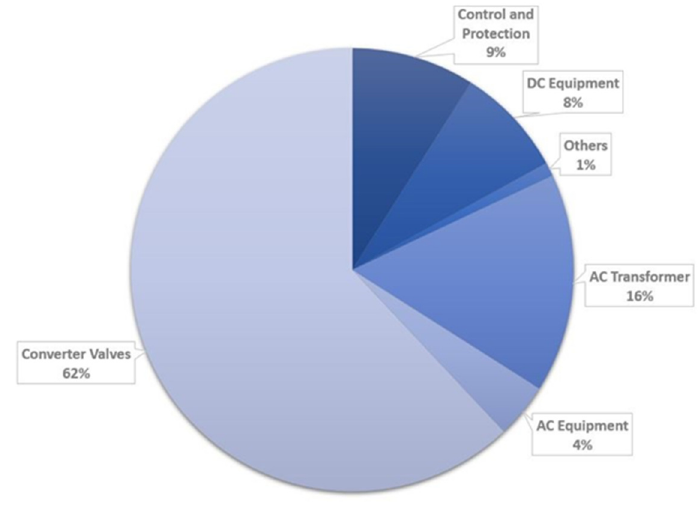
Figure 19. FEU—forced energy utilization for LCC–HVDC.